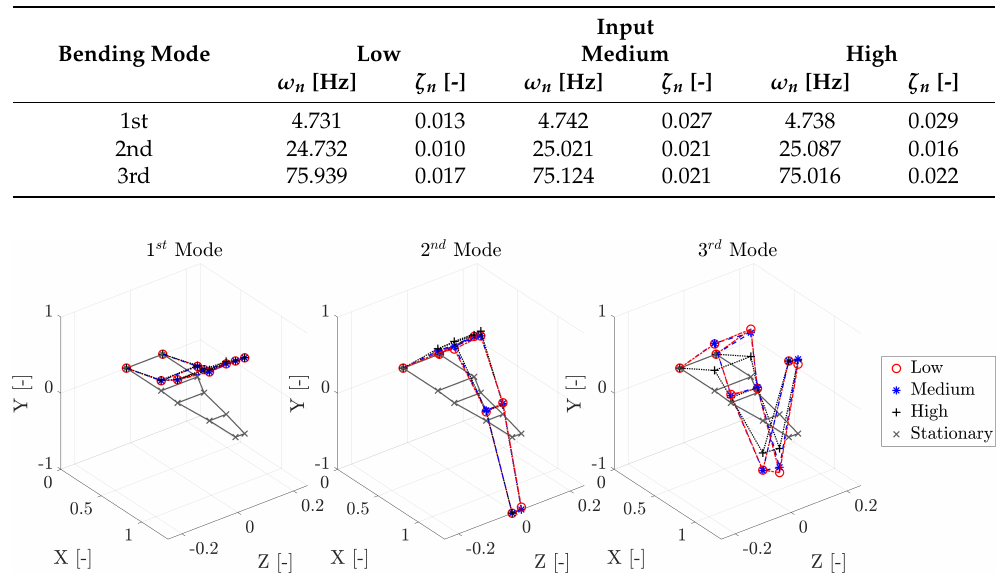
Figure 10. Twin spar: mode shapes of the first three vertically dominant modes.